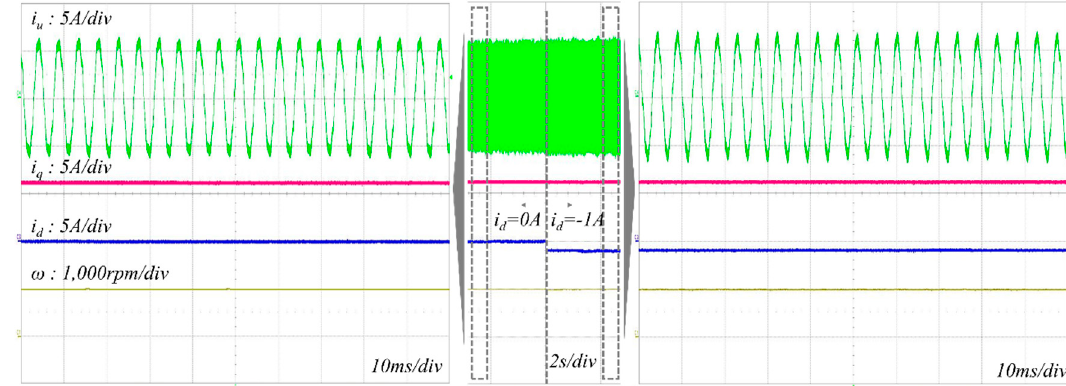
Figure 14. Phase current waveforms when d -axis current was injected at 1000 rpm.